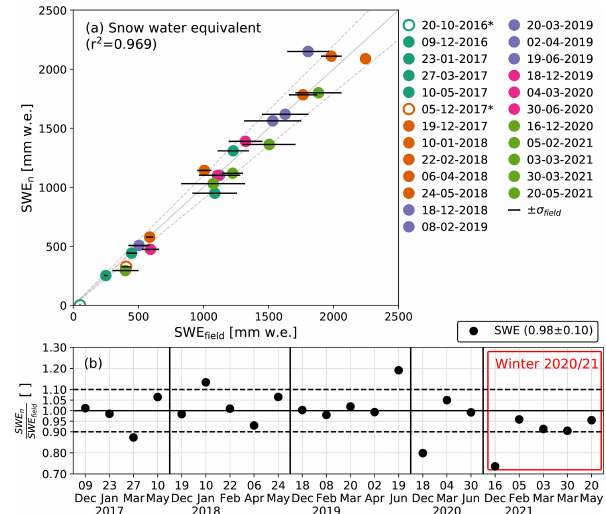
Figure 1. Validation of the n-CRSG. Panel (a) shows SWE derived by the n-CRSG compared to SWE derived manually with a r 2 of 0.969. The field observations on 20 October 2016 and 5 Decem- ber 2017 were done while deploying the devices and are thus not taken into account for the validation. Figure adapted from Gugerli